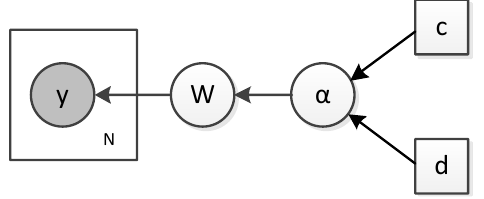
Figure2. Bayesian inference in this case revolves around two